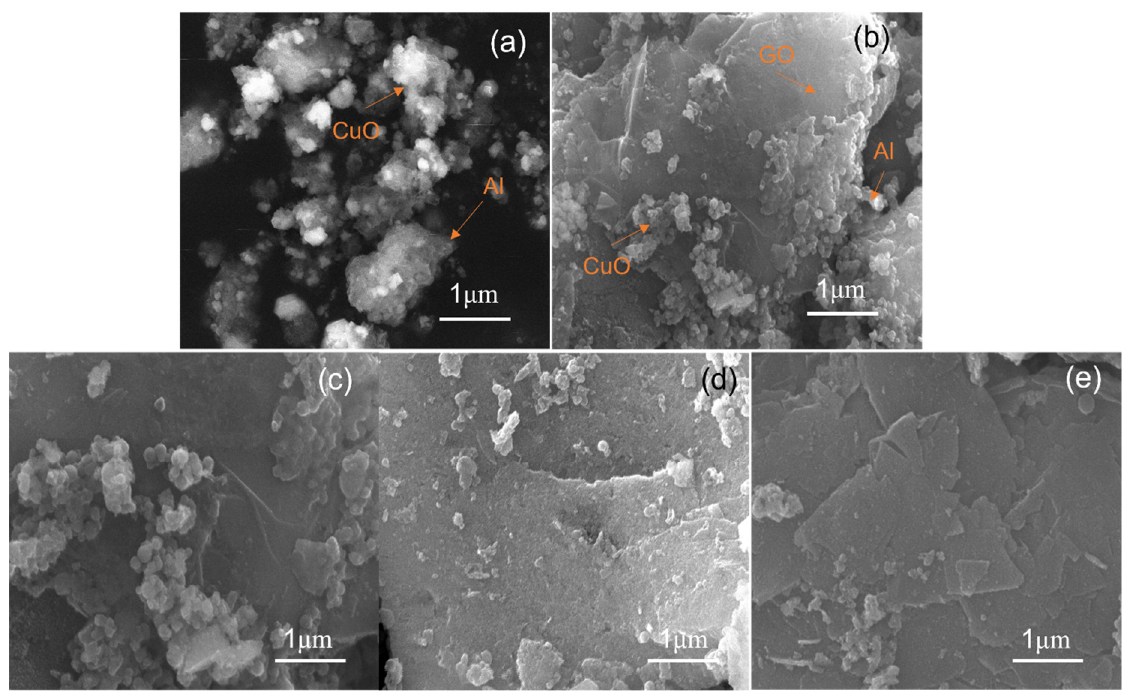
Figure 6. SEM images of Al–CuO/GO with ( a ) 0 wt%, ( b ) 0.5 wt%, ( c ) 1.0 wt%, ( d ) 3.0 wt%, and ( e ) 5.0 wt% of GO. ( e ) 5.0 wt% of